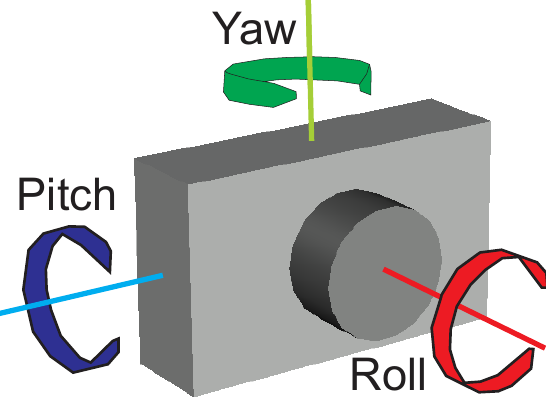
Figure 10. Roll, Pitch and Yaw angles in a camera.